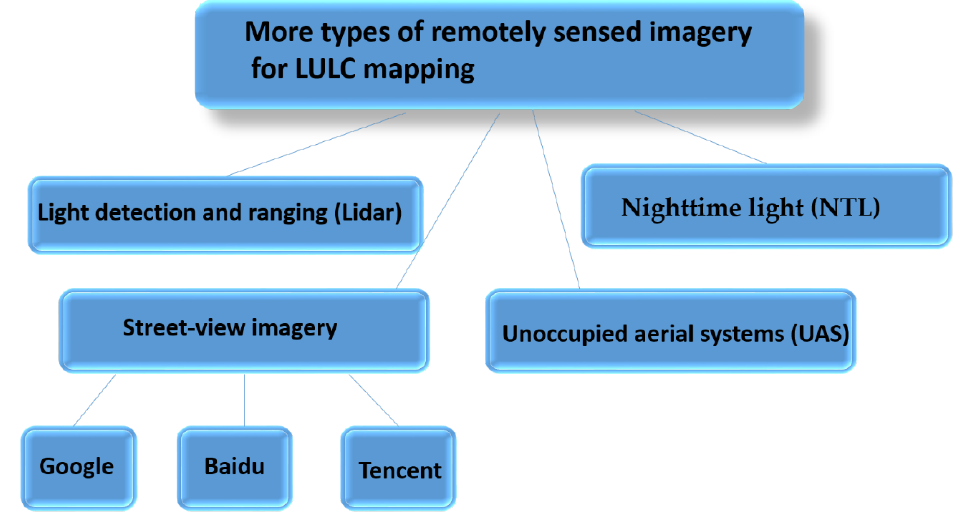
Figure 3. More types of remotely sensed imagery for LULC mapping.